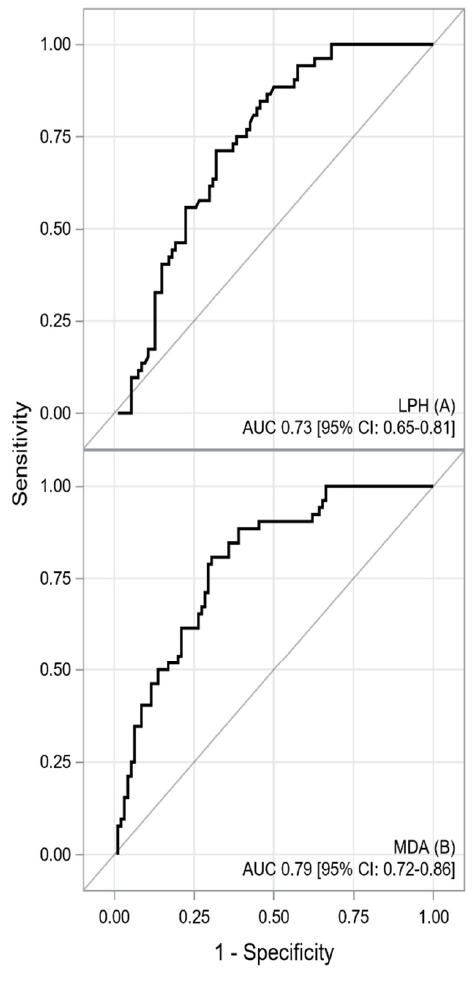
Figure 2. The receiver operating characteristic curve for LPH ( A ) and MDA ( B ) concentrations. Description: The area under the receiver operating characteristic curves indicated acceptable predictive power of LPH and MDA serum concentrations for HCM detection. Abbreviations: AUC—area under